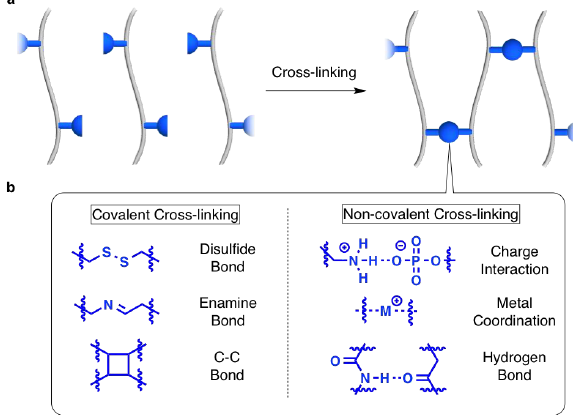
Figure 1. ( a ) Schematic illustration of strategy for cross-linked peptide fibers. ( b ) Chemical cross-linking based on covalent bonds such as disulfide bond, enamine bond, or C-C bond, and physical cross-linking based on non-covalent bonds such as charge interaction, metal coordination, or hydrogen bond are available depending on purposes.